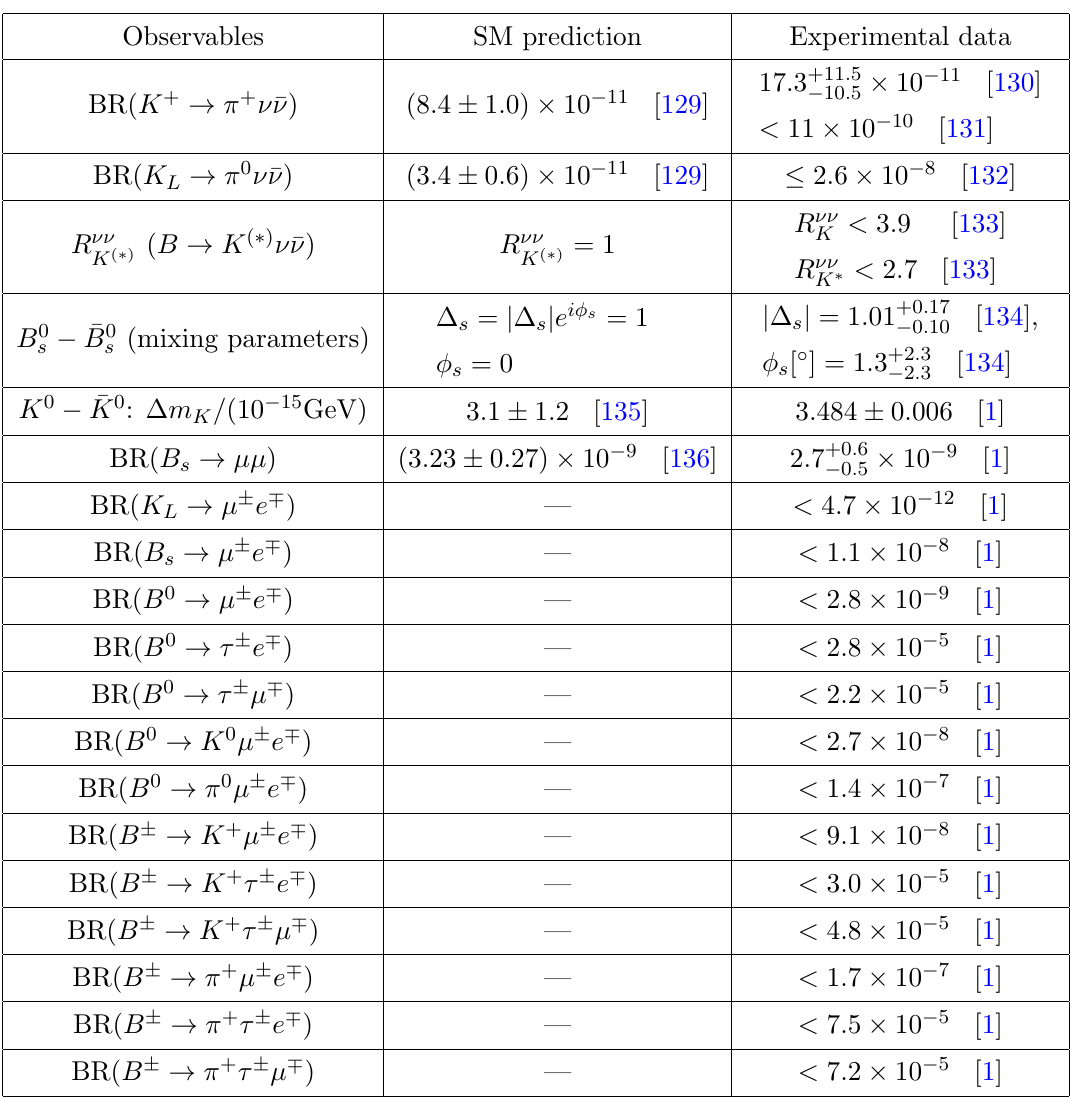
Table 1 . Relevant observables and current experimental status for leptonic and semi-leptonic meson decays; when appropriate, the associated SM prediction is also